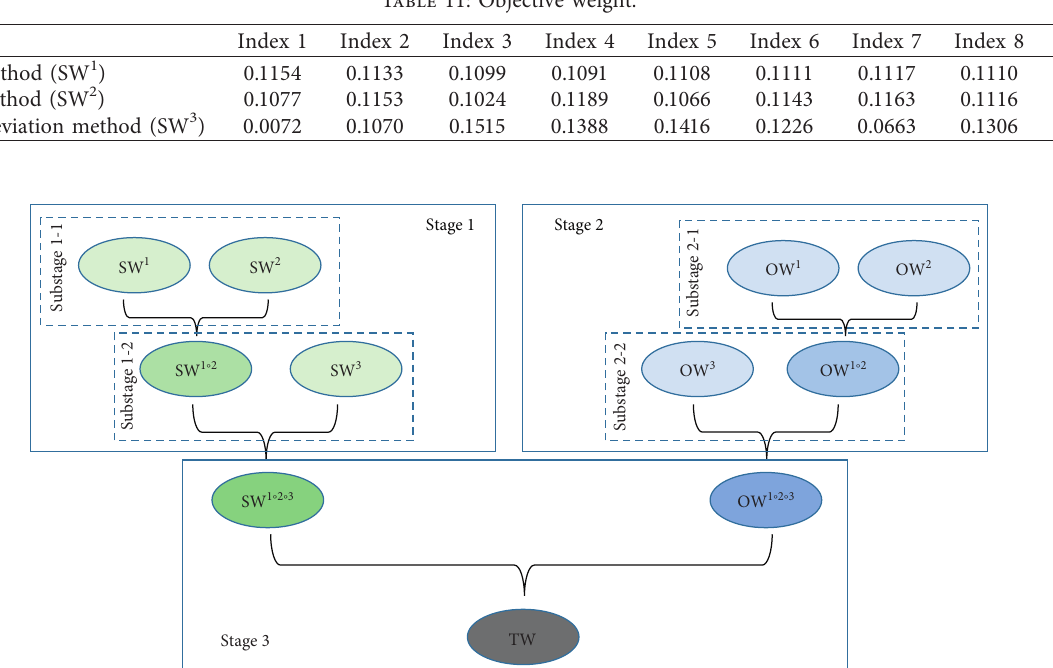
Figure 10: The weight synthesis